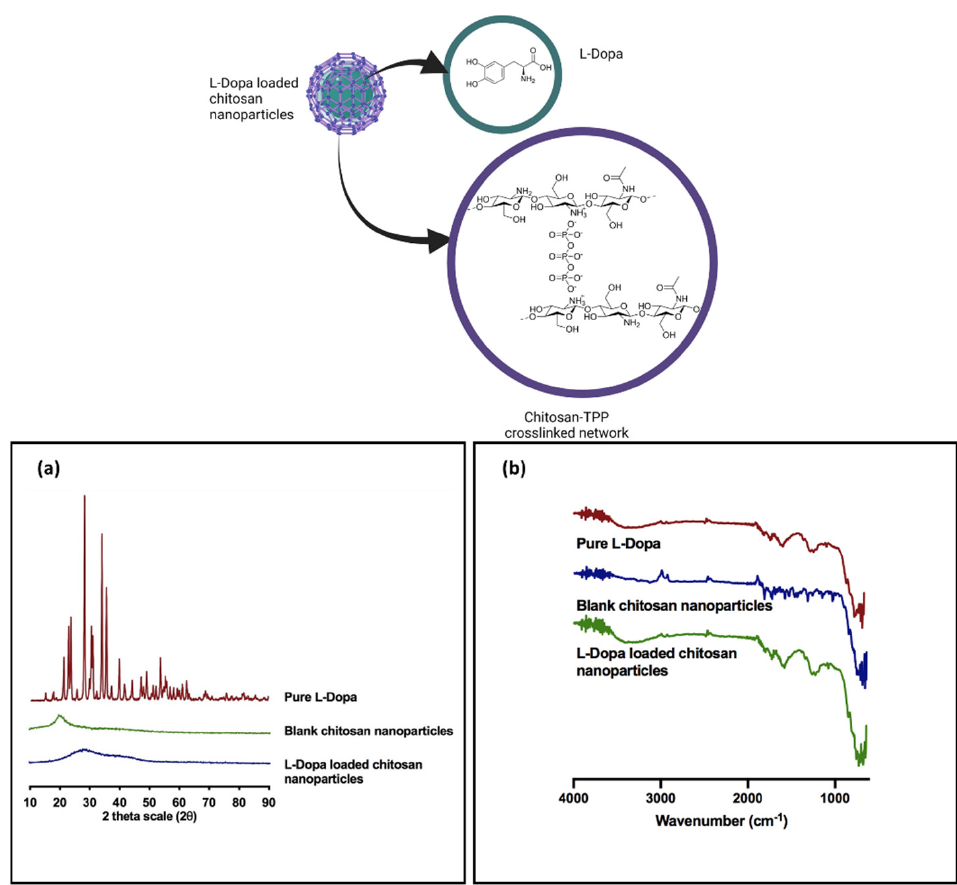
Figure 4. Physical characterisation of L-Dopa loaded chitosan nanoparticles. ( a ) Diffractogram of pure L-Dopa, blank chitosan nanoparticles and L-Dopa loaded chitosan nanoparticles. ( b ) FTIR spectrum of pure L-Dopa, blank chitosan nanoparticles and L-Dopa loaded chitosan nanoparticles. The XRD diffractogram of blank chitosan showed a typical amorphous